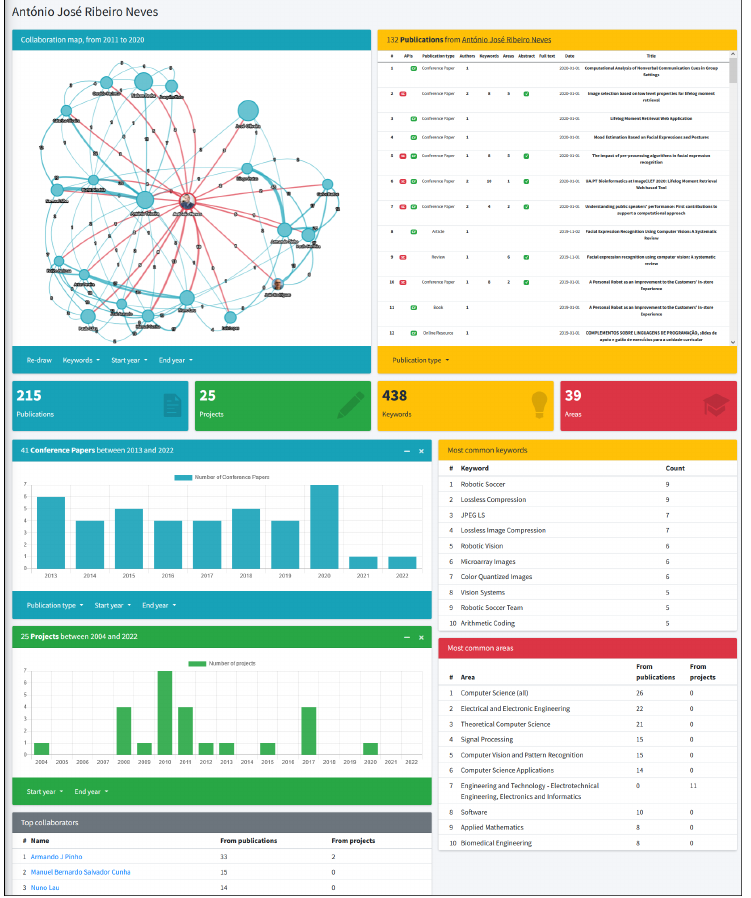
Figure 5. Overview of an author’s